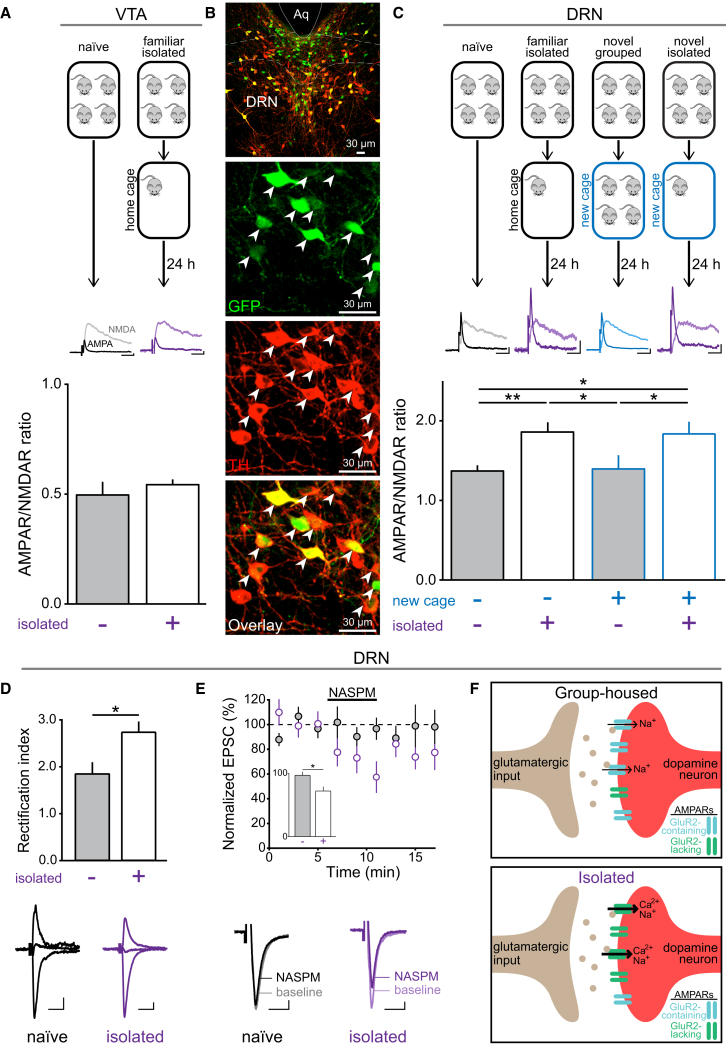
24 Hours of Social Isolation Induces Synaptic Potentiation onto DRN DA Neurons(A) AMPAR/NMDAR ratios recorded from VTA DA neurons in mice socially isolated for 24 hr (n = 12) were not significantly different from group-housed mice (n = 8; unpaired t test: t18 = 0.73, p = 0.47).(B) Low- (upper panel) and high-magnification (lower panels) confocal images of the DRN from a TH-GFP mouse showing GFP-expressing (green) and post hoc immunohistochemically verified TH-expressing (red) DA neurons with white arrows indicating co-labeled neurons.(C) AMPAR/NMDAR ratios recorded from DRN DA neurons in mice socially isolated for 24 hr, either in a familiar cage or a novel cage (familiar isolated or novel isolated, respectively), were significantly greater than group-housed mice in familiar or novel cages (one-way ANOVA: F3,47 = 5.910, ∗∗p = 0.0017; Newman-Keuls post hoc tests: ∗p < 0.05, ∗∗p < 0.01; n = 19 naive, 17 familiar isolated, 9 novel grouped, and 6 novel isolated). Scale bars, 20 pA, 20 ms.(D) The AMPAR rectification index in DRN DA neurons was significantly greater in socially isolated mice, relative to naive mice (unpaired t test: t21 = 2.417, ∗p = 0.0248, n = 9 naive, 14 isolated).(E) Normalized AMPAR-mediated EPSC amplitude during bath application of NASPM, and representative averaged EPSCs from a naive and socially isolated mouse (inset shows % change in EPSC amplitude following NASPM, relative to baseline). NASPM significantly reduced EPSC amplitude in socially isolated mice (n = 7), relative to naive mice (n = 8; unpaired t test: t13 = 2.853, ∗p = 0.0136). Scale bars, 10 pA, 10 ms.(F) Proposed model of AMPARs at synapses onto DRN DA neurons in group-housed mice and following social isolation.Data are represented as mean ± SEM. See also Figure S1.